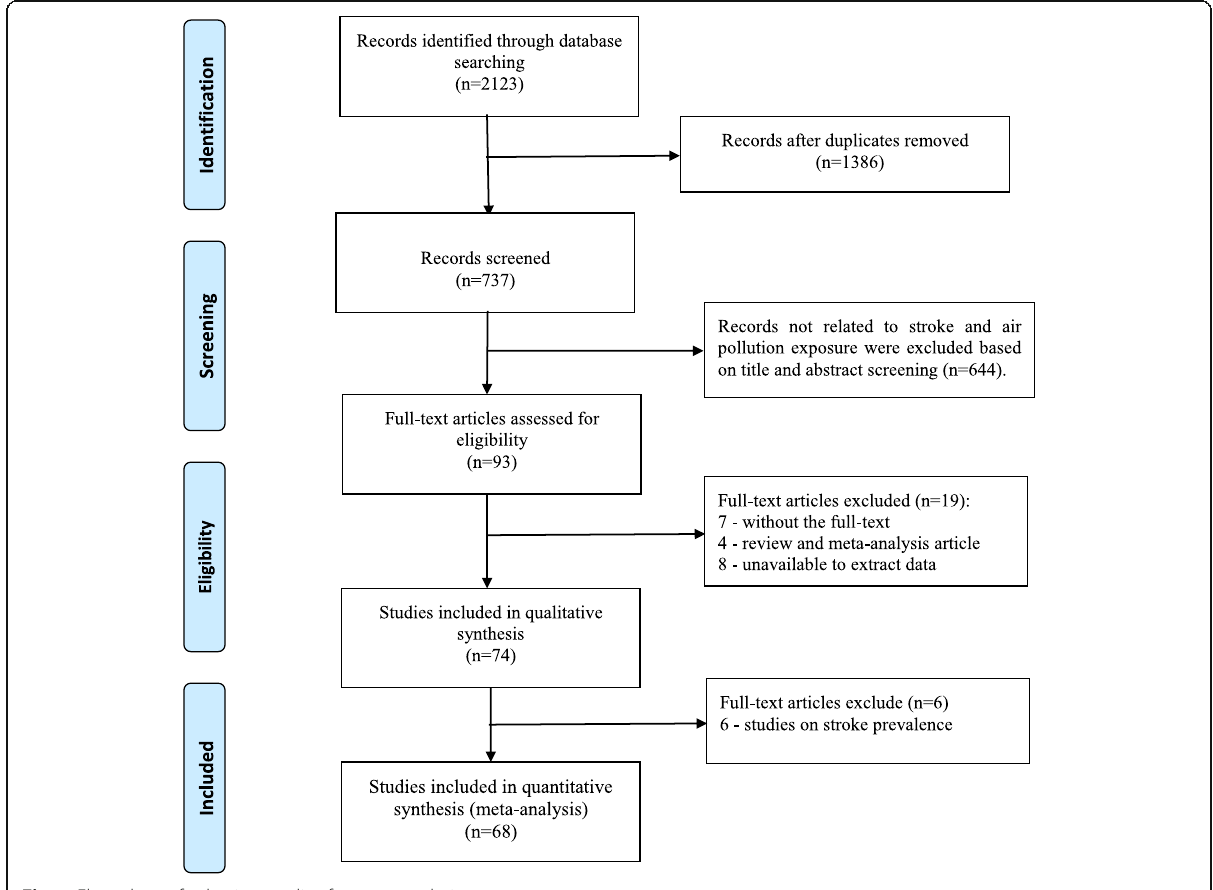
Fig. 1 Flow chart of selecting studies for